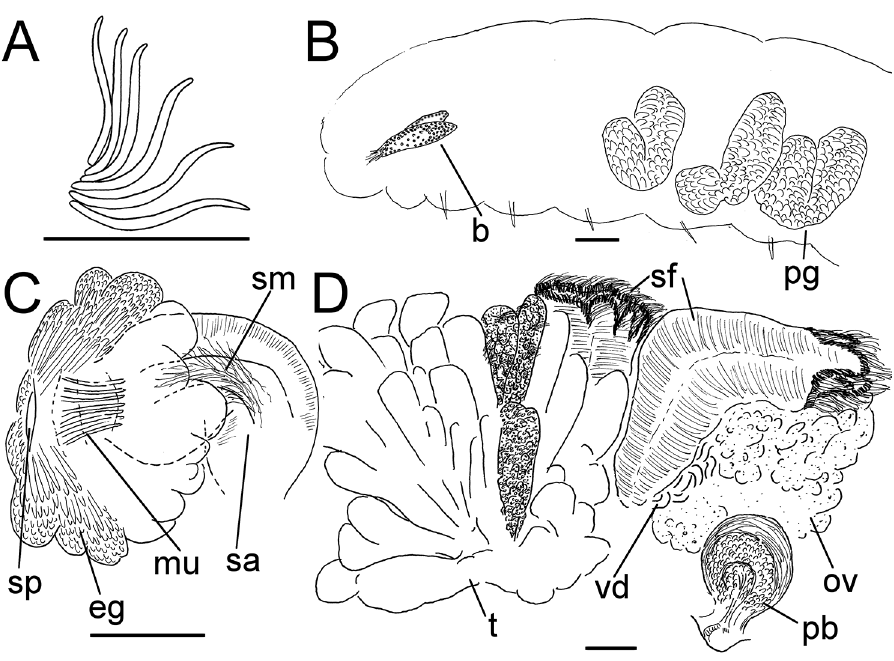
Figure 7. Lumbricillus rivalis . A Chaetal bundle B Anterior body C Spermatheca D Other genitalia. Abbreviations under general notes. Scale bars: 100